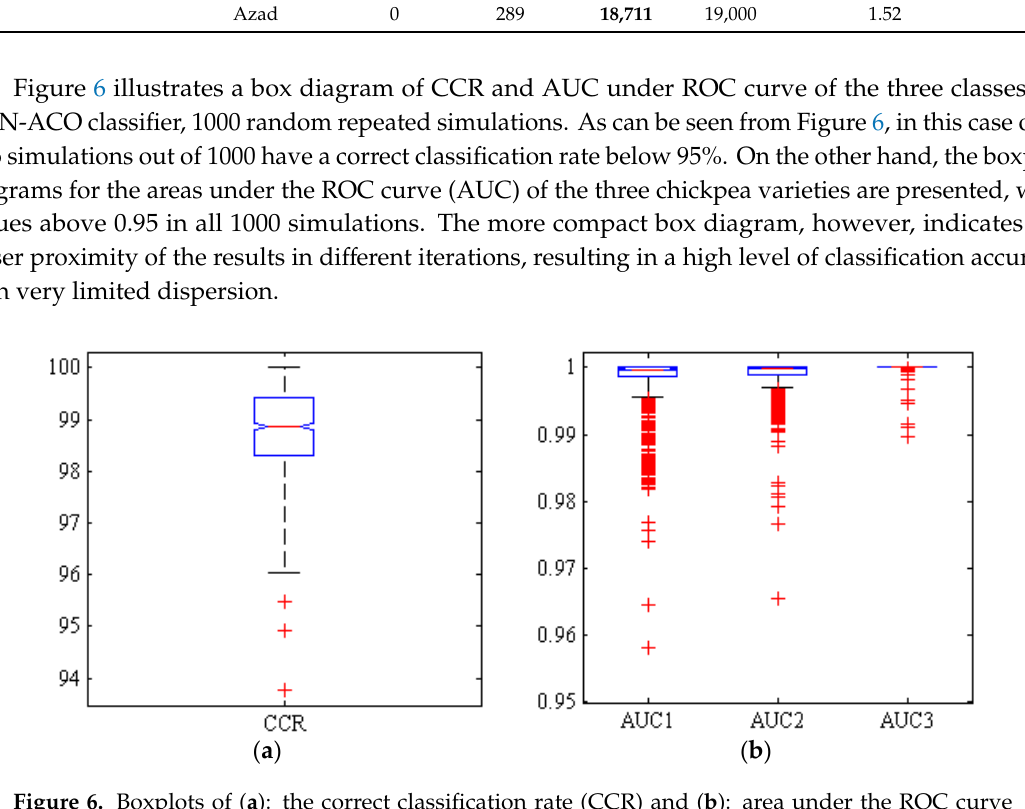
Figure 6. Boxplots of ( a ): the correct classification rate (CCR) and ( b ): area under the ROC curve (AUC) by hybrid ANN-CO classifier, for Adel (AUC1), Arman (AUC2) and Azad (AUC3) chickpea ( Cicer arietinum L.) varieties (1000 uniform random iterations, test set).